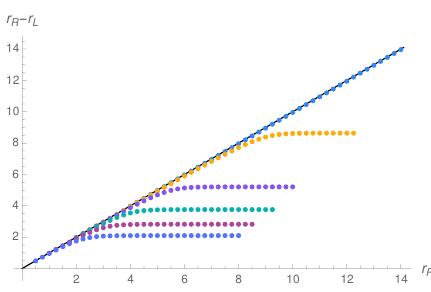
Figure 9 . Difference r R − r L between the end points at x → ±∞ at finite temperature, with r h = 0 , from bottom to top for N 5 /K ∈ { 2 . 25 , 2 . 75 , 3 . 25 , 3 . 75 , 4 . 25 } . The solid black line shows r L = 0